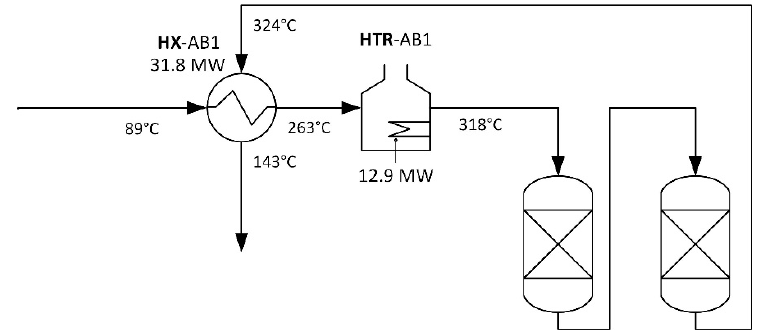
Figure A1. Existing process configuration of effected part of Unit A.